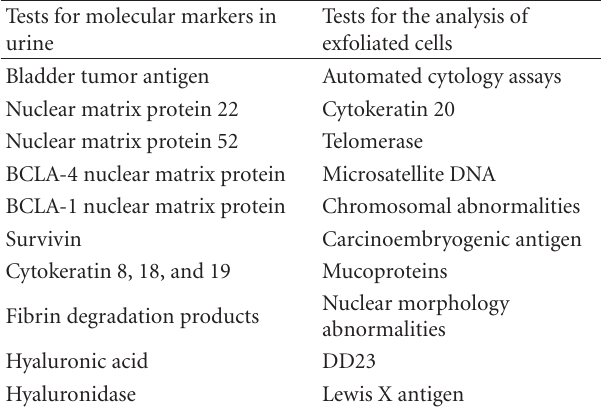
Table 1: Di ff erent methods for studying urine